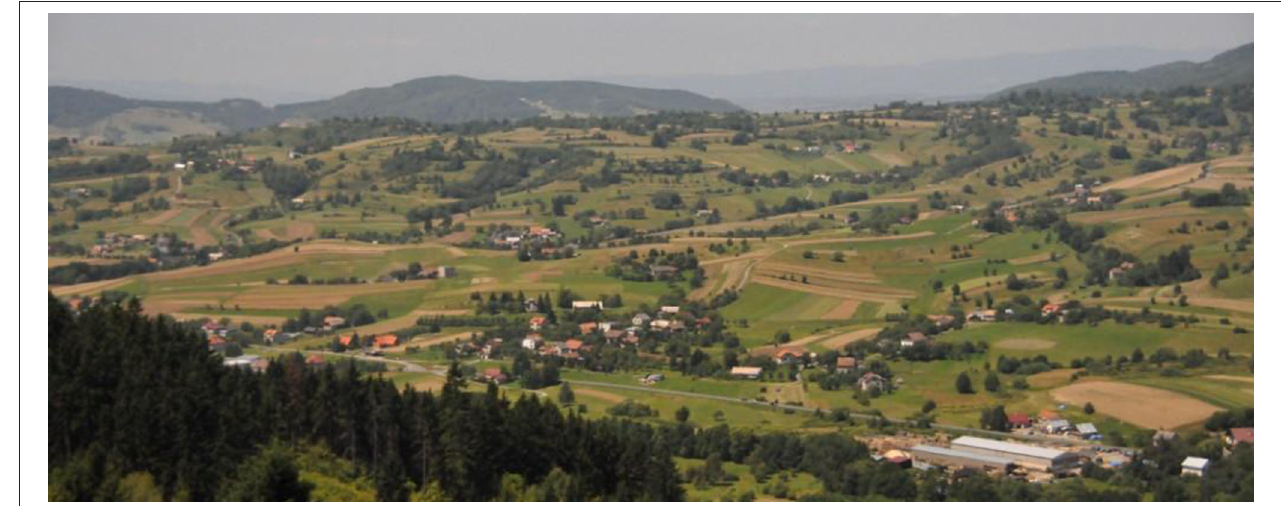
FIGURE 9 | Landscape with dispersed settlement in the Detva region (Hrinová, J. Špulerová).